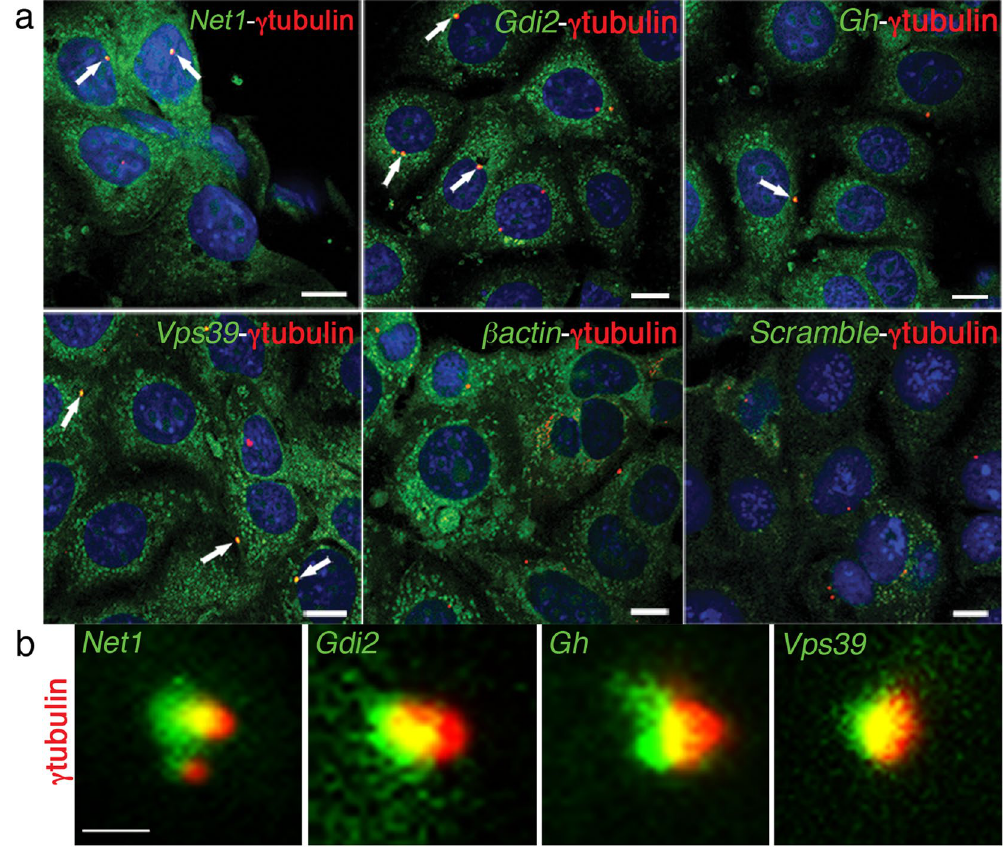
Figure 7. OFD1 target mRNAs localize at the centrosome. ( a ) Net1, Gdi2, Gh and Vps39 mRNAs (green) colocalize with γ tubulin (red) at the centrosome in IMCD3 cells (arrows indicate merged signals). β actin and scrambled probes (green) were used as controls. Bar = 10 μ m. ( b ) Superresolution images show target mRNAs (green) and γ tubulin (red) colocalization. Bar = 2 μ m. Representative images were taken at the same contrast and